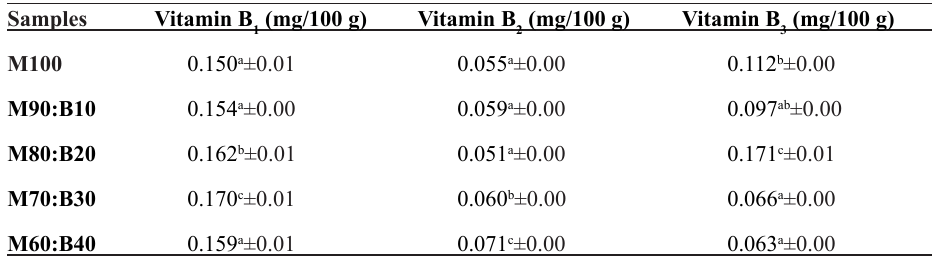
Table 4: Vitamin composition of maize-bambara nut composite flours.